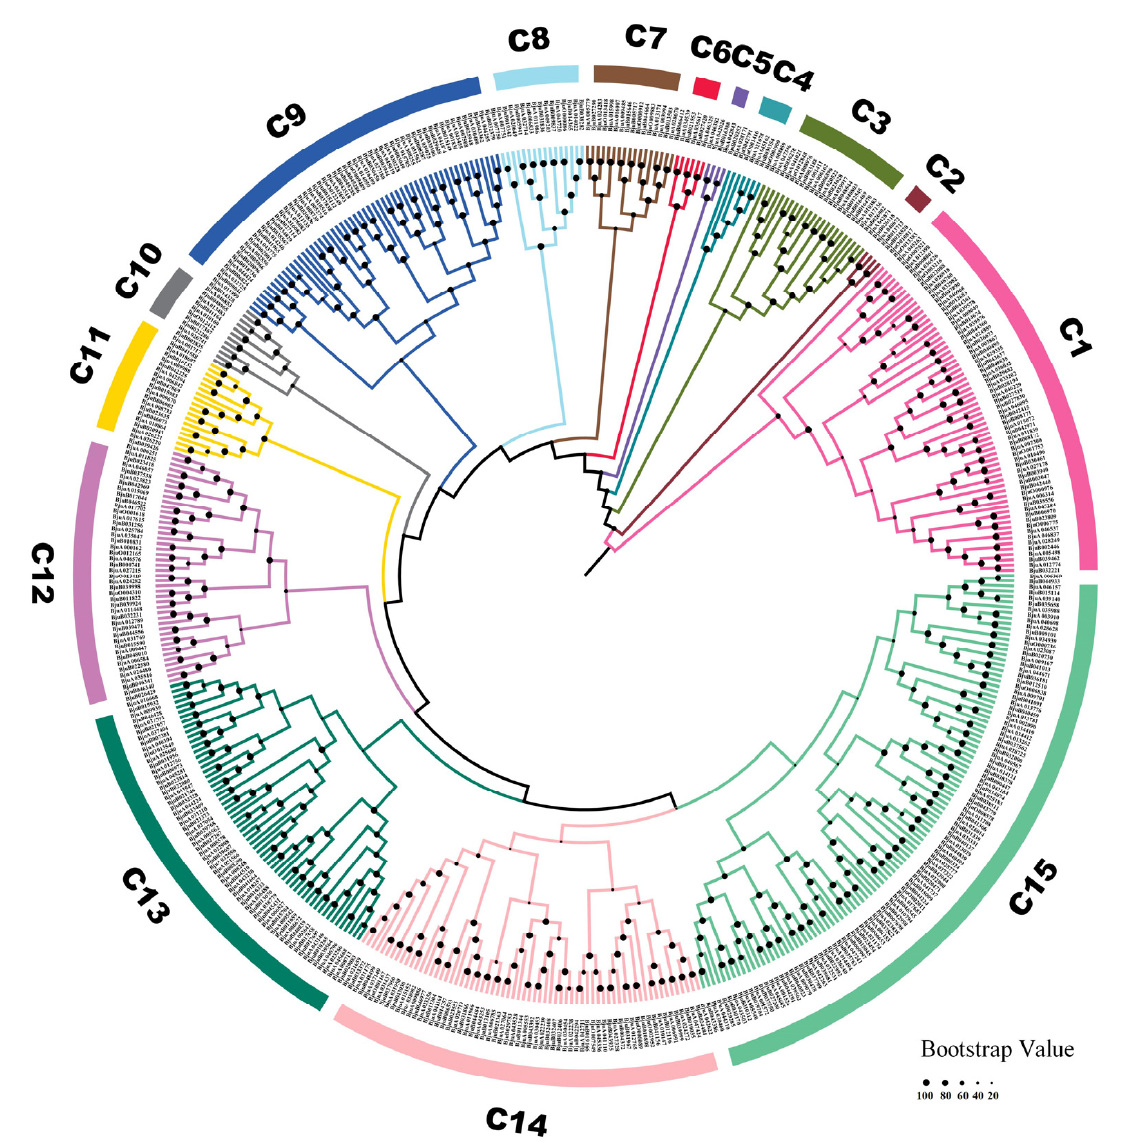
Figure 1. Phylogenetic analysis of MYB transcription factors from Brassica juncea. The protein sequences of 502 BjMYB transcription factors were aligned using the MUSCLE tool, and the neighbor-joining (NJ) method (bootstrap replications, n = 1000) was used to generate the phylogenetic tree with MEGA 11. The phylogenetic tree was highlighted with FigTree (version 1.4.4). The proteins are clustered into 15 distinct groups designated by a group number C1~C15 and labeled with different colored branches.